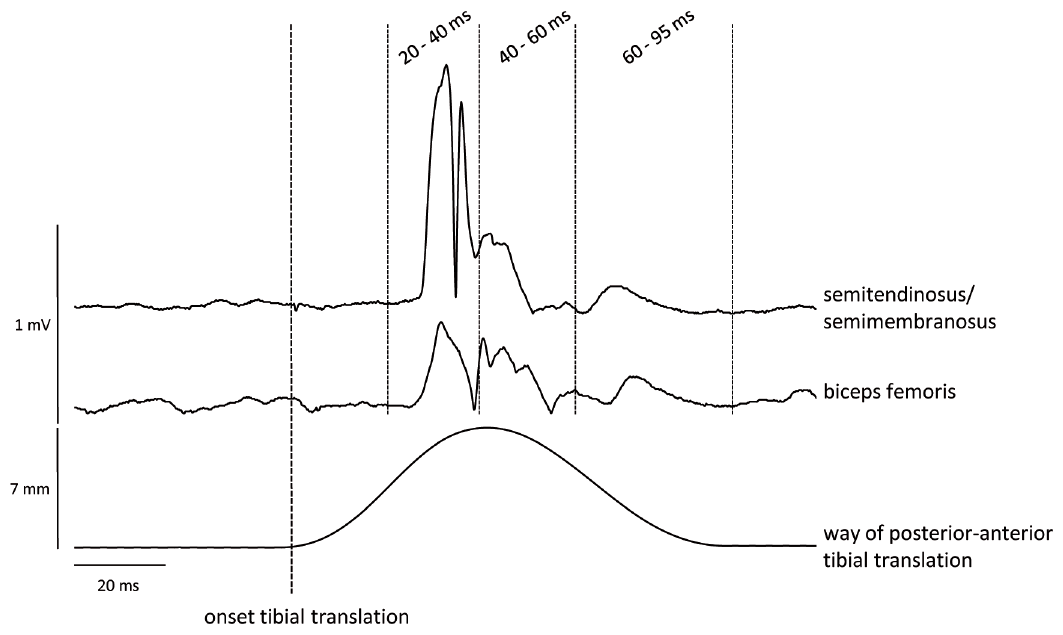
Figure 2. EMG and tibial translation data from one representative subject. EMG activity of biceps femoris and semitendinosus/ semimembranosus as well as posterior-anterior tibial translation of one subject. In the figure, EMG data is rectified in order to visualize the different parts of the hamstring stretch reflex. The vertical bold line indicates the onset of posterior-anterior tibial translation. Three different time intervals were analyzed (20–40, 40–60 and 60–95 ms).